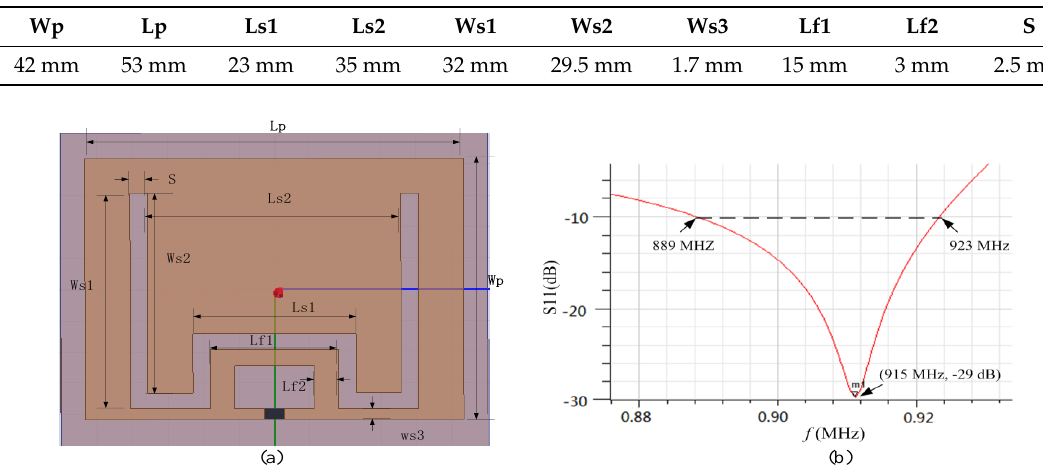
Figure 4. Proposed patch antenna: ( a ) antenna design; ( b ) return-loss in air.